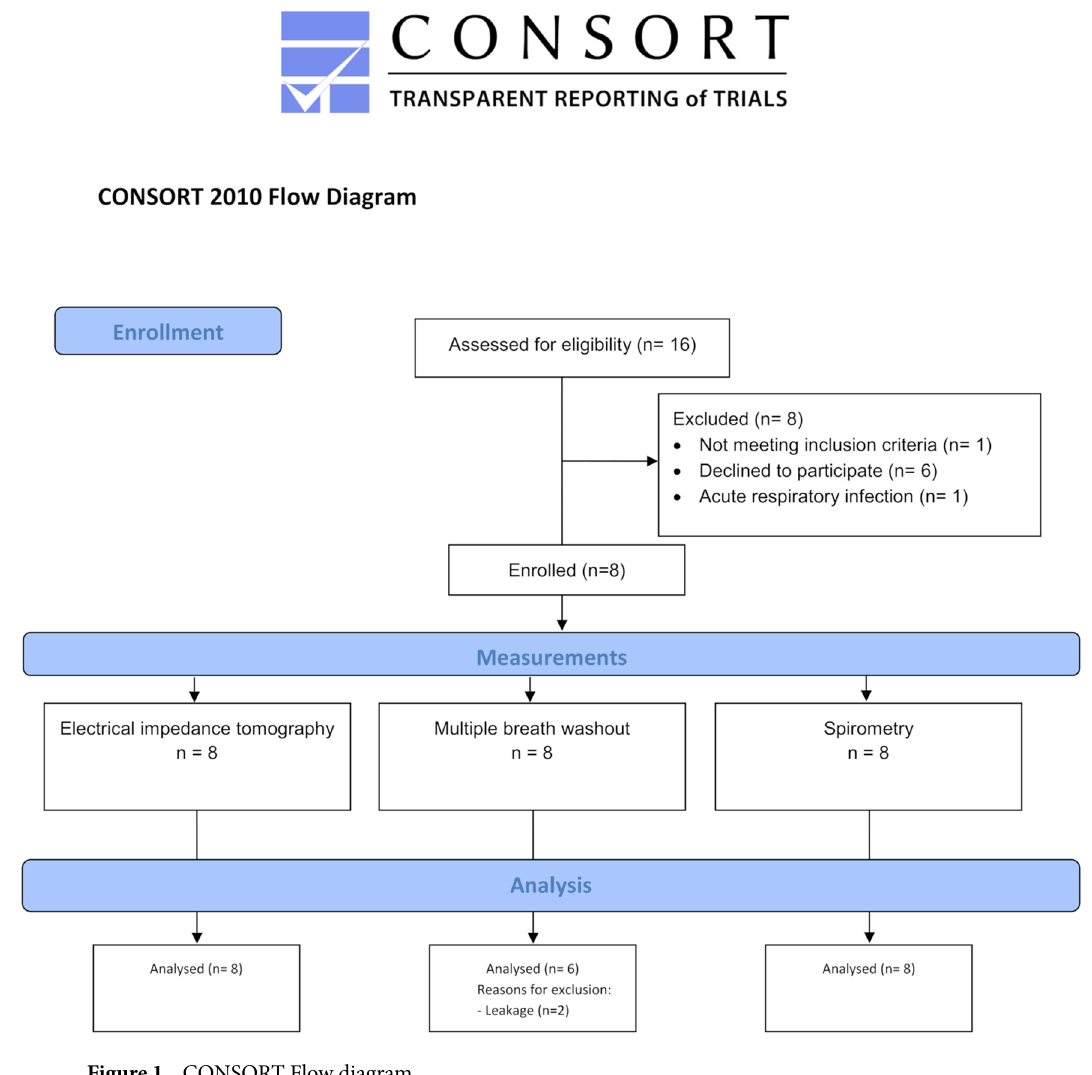
Figure 1. CONSORT Flow diagram.